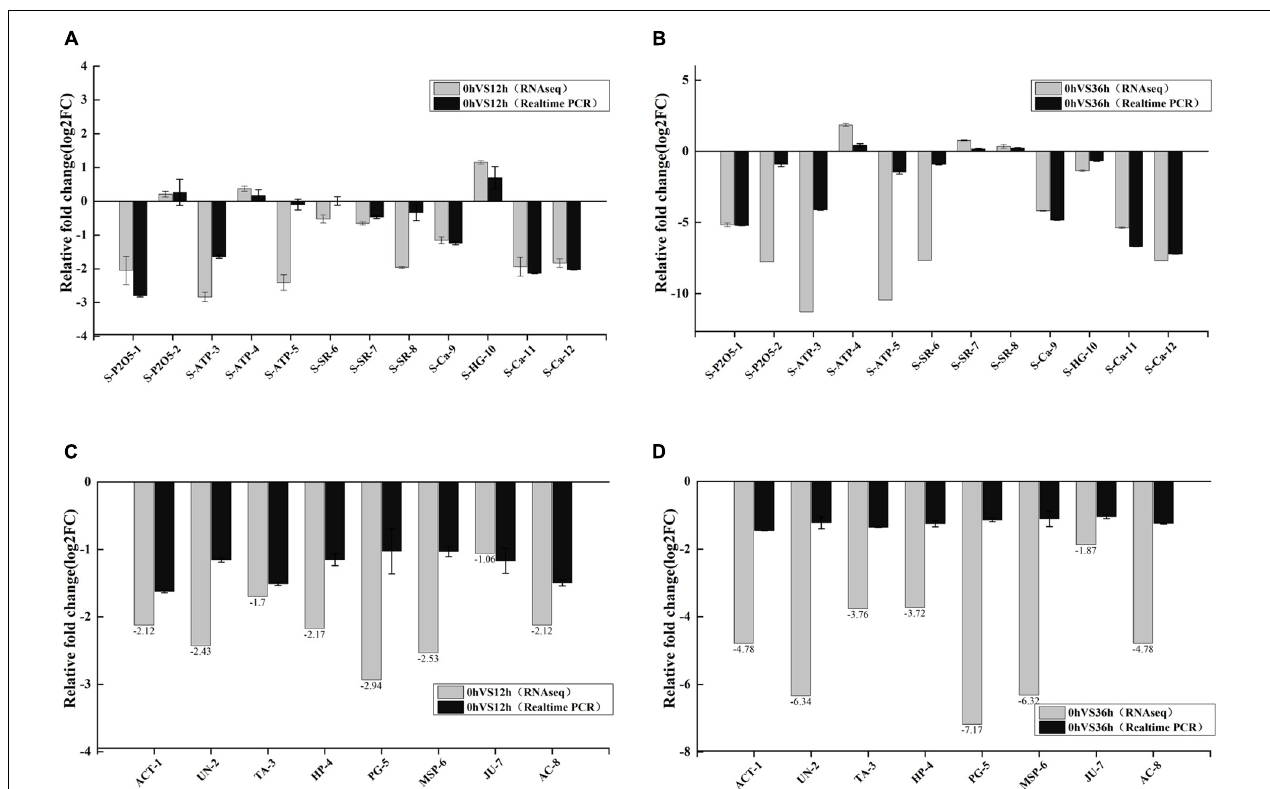
FIGURE 11 | The results were verified by quantitative PCR (qPCR). (A,B) Relative fold change of different mRNAs between qPCR and mRNA-sequencing results in the transcriptome. Relative expression levels from the RNA-seq results were calculated as log 2 FC values. (C,D) qPCR validation of co-existing differentially expressed genes (DEGs)/differentially expressed proteins (DEPs) in 0 vs. 12 h and 0 vs. 36 h groups. Relative expression levels from the RNA-seq results were calculated as log 2 FC